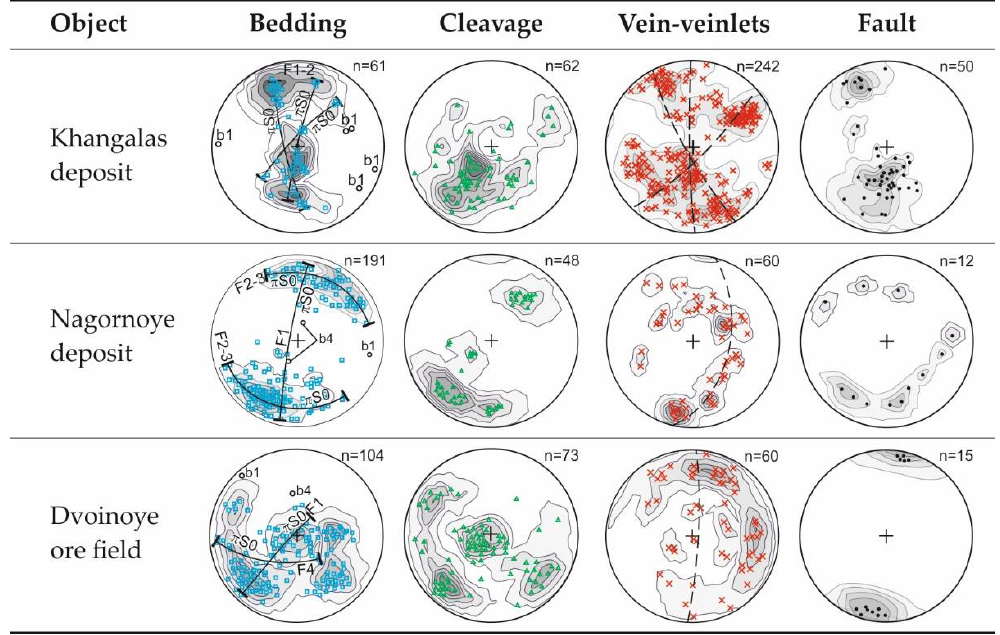
Figure 9. Stereograms of poles of bedding, cleavage, veins and faults, Khangalas ore cluster. Dashed line, belt of vein poles. Contours of poles to planes (per 2% area).